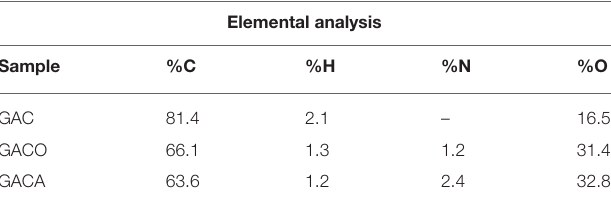
TABLE 3 | Results of the elemental analysis of carbonaceous